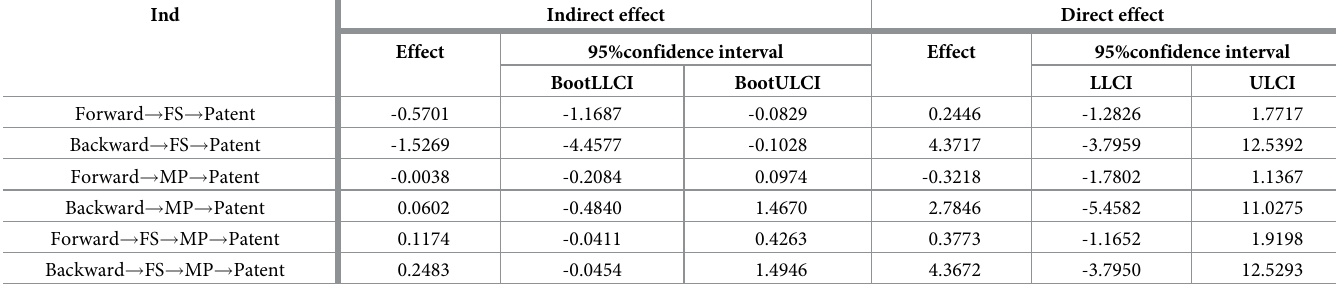
Table 9. Enterprises with low marketization